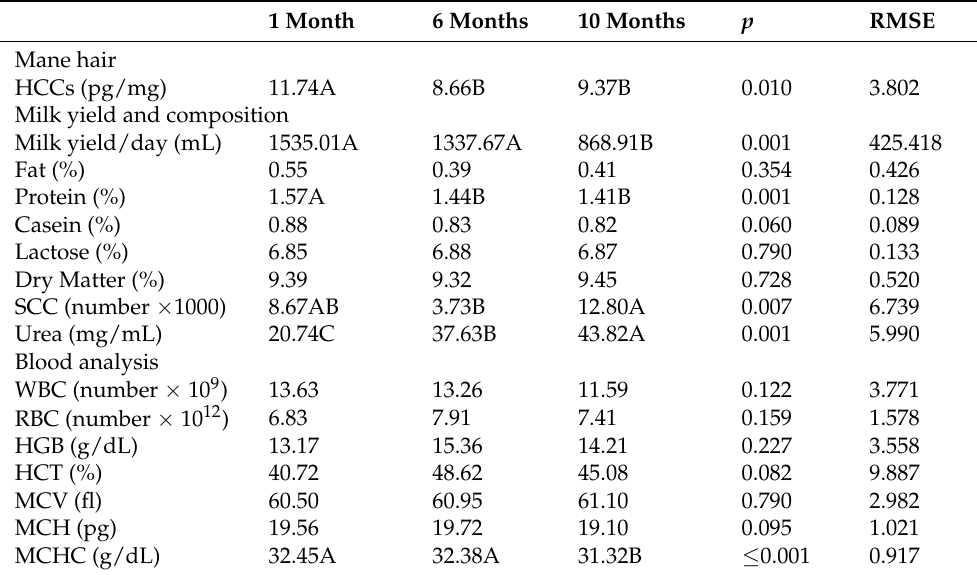
Table 1. Effects of the lactation phase on hair cortisol, milk production and blood